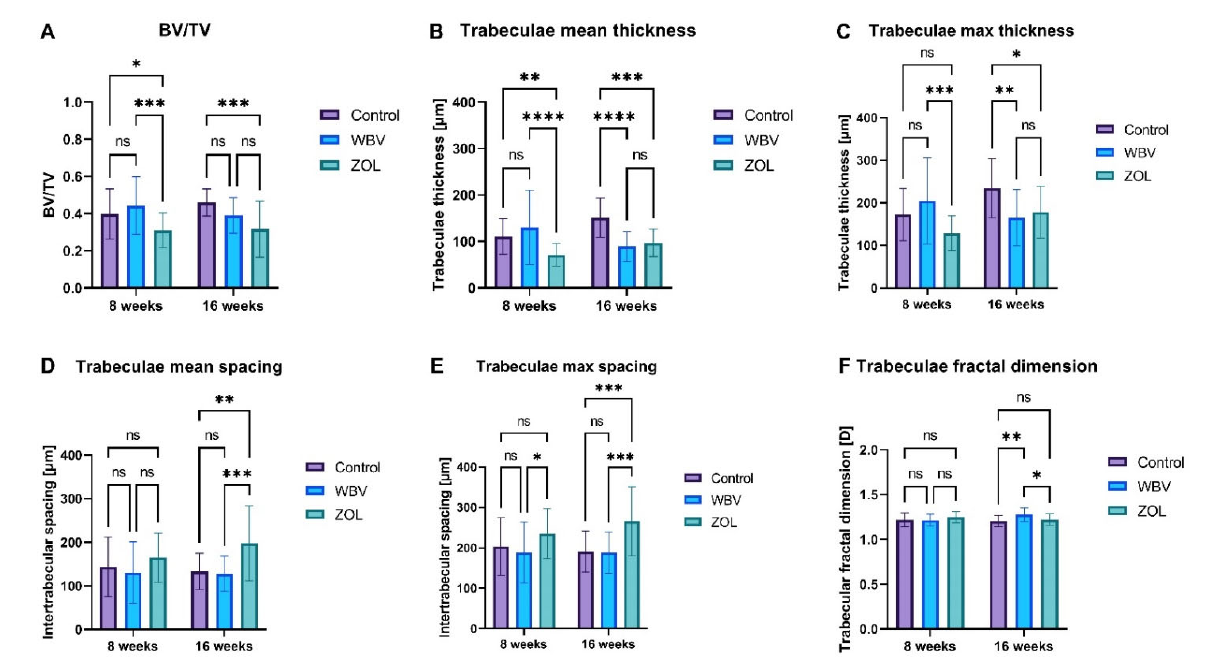
Figure 3. The effect of whole-body vibration (WBV) or zoledronic acid (ZOL) supplementation on the trabecular morphology in femur distal metaphysis in rats subjected to obesity and immobility: ( A ) bone volume fraction (BV/TV); ( B ) trabeculae maximum thickness; ( C ) trabeculae mean thickness; ( D ) trabeculae mean spacing; ( E ) trabeculae maximum spacing; ( F ) trabeculae fractal dimension. Control—the control group included rats subjected to obesity and immobility not treated with WBV or ZOL; WBV—the WBV group included rats subjected to obesity and immobility with whole ‐ body vibration treatment (30 min, 5 days per week); ZOL—the ZOL group included rats subjected to obesity and immobility and intramuscularly with zoledronic acid at a dose of 0.025 mg/kg body weight every 4 weeks. Data are mean values ± SD from n = 6 rats. Statistical significance: ns—not significant; * p < 0.05; ** p < 0.01; *** p < 0.001; **** p < 0.0001 (Tukey’s HSD test or Kruskal–Wallis H test).